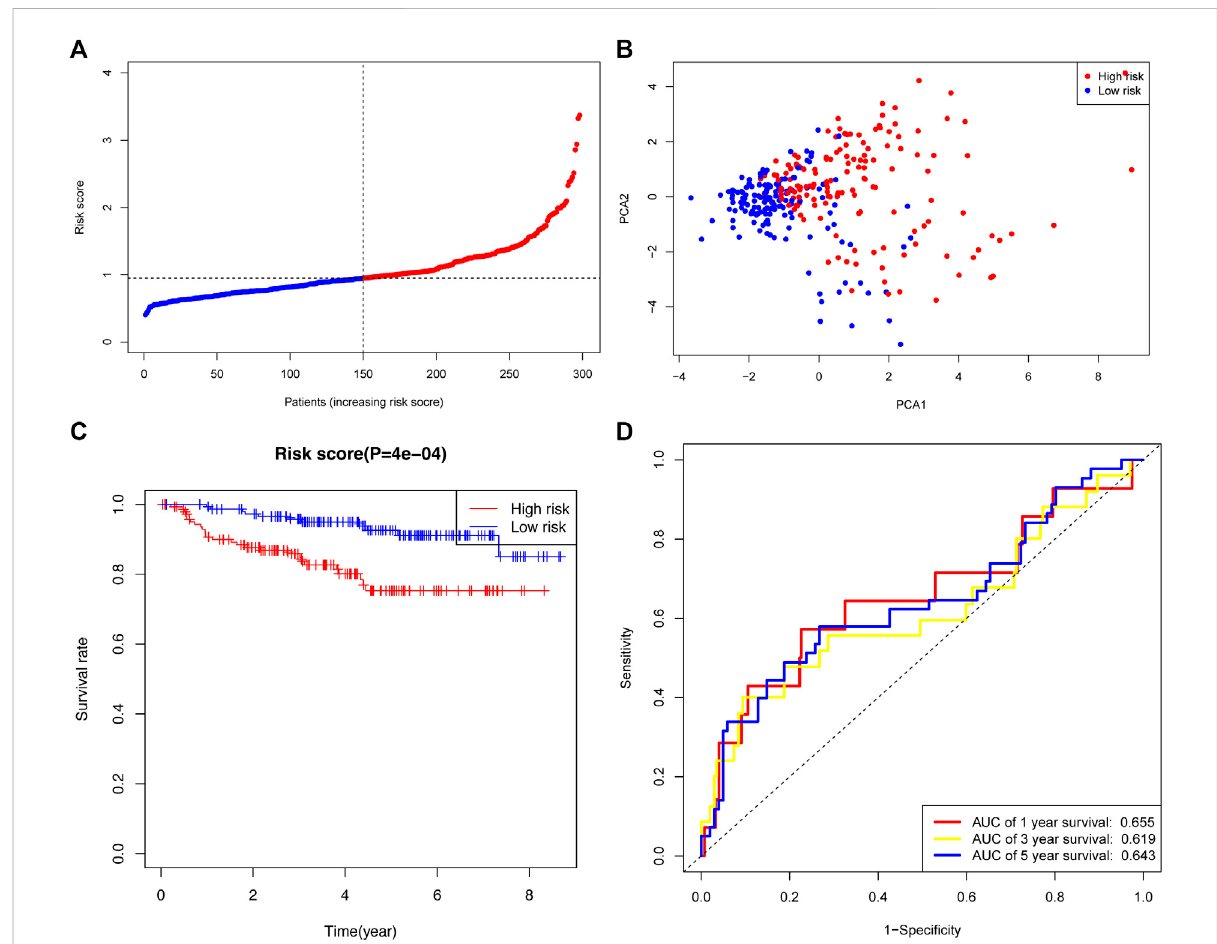
FIGURE 6 Validation of the risk signature in the GEO cohort. (A) Distribution and median risk score in the GEO cohort. (B) PCA distribution plot. (C) Kaplan – Meier curves of cervical cancer between the two risk groups. (D) AUC values of the ROC curve of the risk score in the GEO